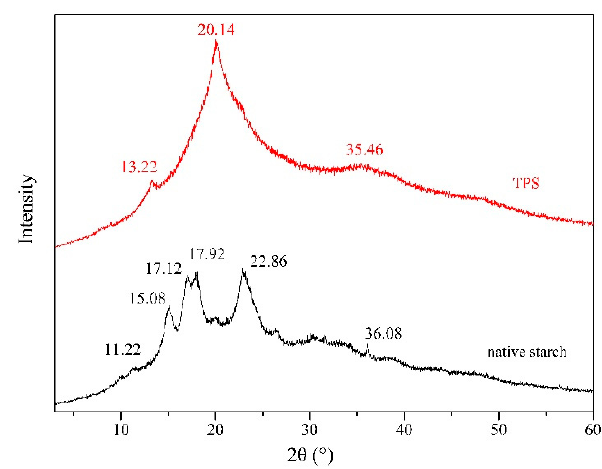
Figure 3. XRD spectra of pristine cassava starch and plasticized starch.